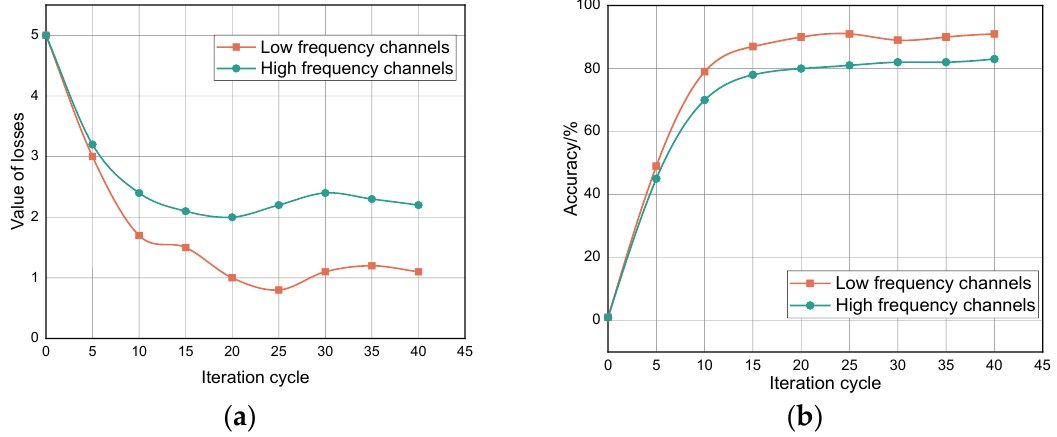
Figure 9. ( a ) Variation in sample loss rate. ( b ) Variation in sample accuracy rate.